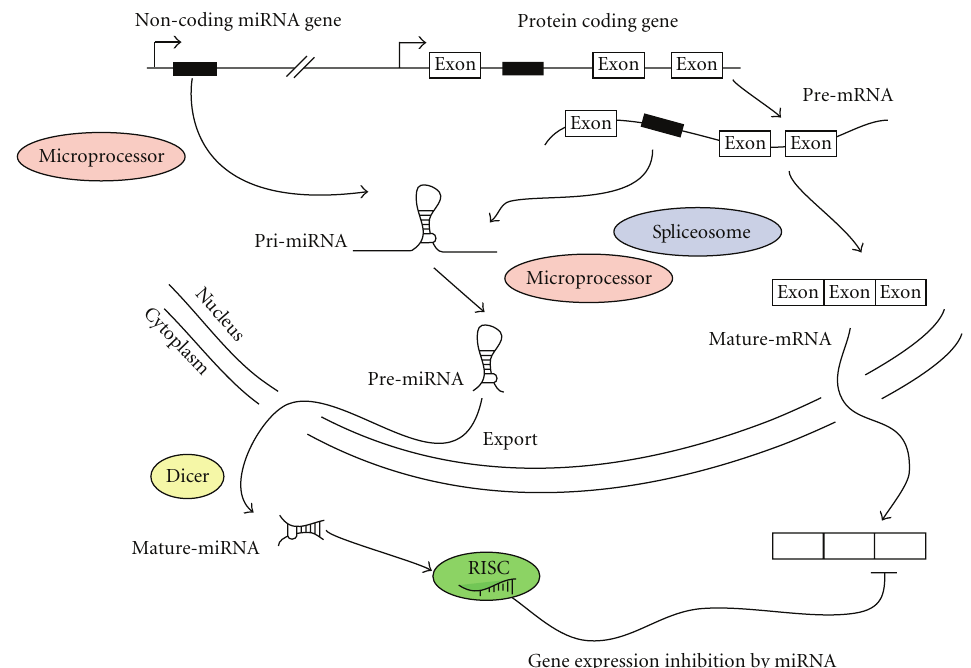
Figure 1: The canonical miRNA biogenesis pathway and its a ff ect on gene expression. Elaborated mechanisms and exceptions to this pathway are reviewed in [24].